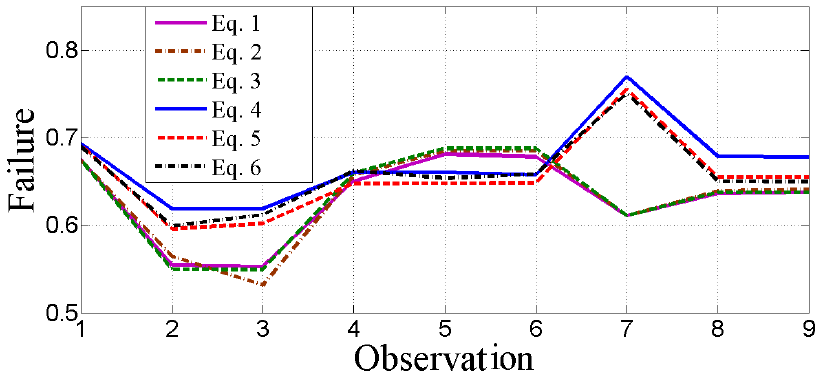
Figure 6. Monitoring the general condition of the equipment.